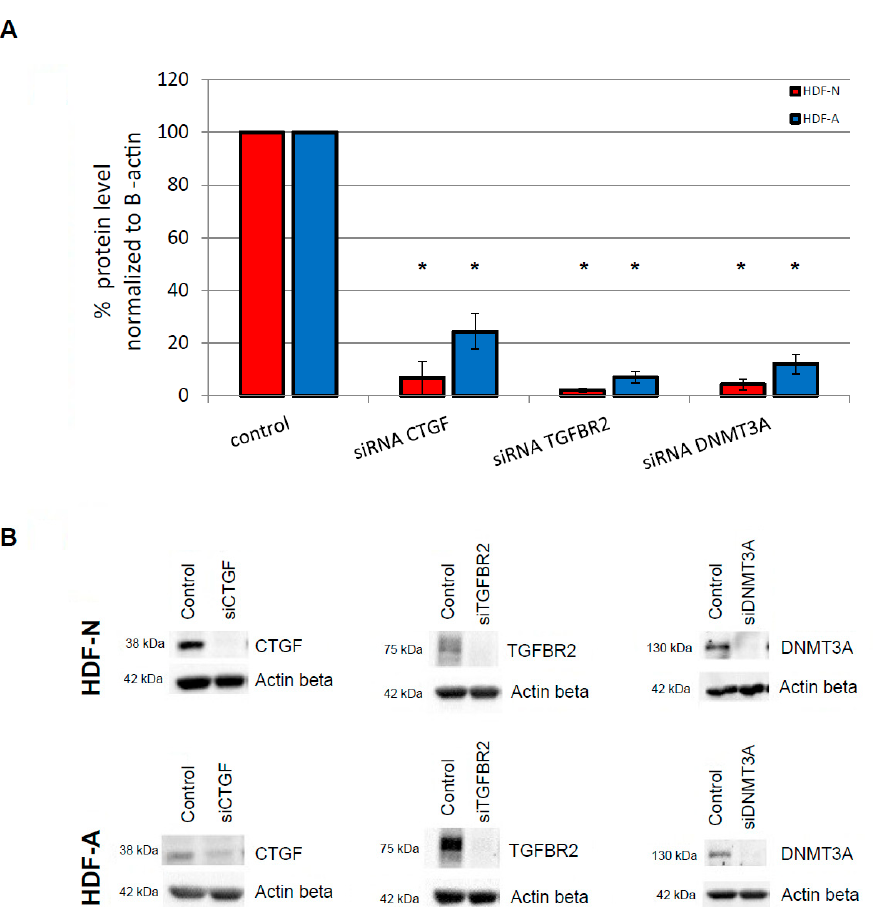
Figure 1. Verification of specificity of siRNA on CTGF, TGFBR2, and DNMT3A proteins in neonatal (HDF-N) and adult (HDF-A) human dermal fibroblasts. Cells treated with control siRNA were considered as an experimental control (with a value of 100%) in comparison with the protein levels in cells treated with various specific siRNAs. Protein levels were normalized to Actin β . ( A ) The protein levels of CTGF, TGFBR2, and DNMT3A after silencing with specific siRNAs are significantly reduced in HDF-N and HDF-A cells (* p -value < 0.05). Error bars represent standard error of the mean. ( B ) Representative immunoblots show the specificity of analyzed proteins: significantly reduced protein level in cells treated with various specific siRNAs in the evaluated cell